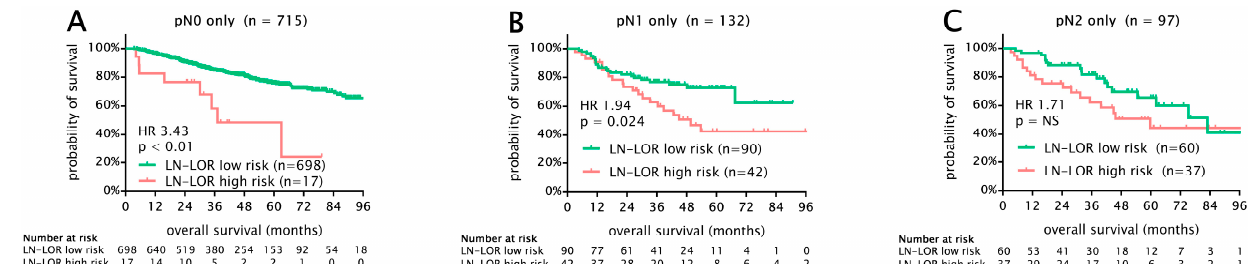
Figure 3. Kaplan–Meier survival analysis for OS in 944 patients with stage I-III NSCLC undergoing curative intent lobectomy. Survival analysis stratified by pN categories and LN-LOR risk groups. ( A ) OS in pN0 patients only. LN-LOR high risk was associated with significantly worse OS (5-year OS 76% vs. 48%, p < 0.01) among pN0 patients. Importantly, 17 patients in the LN-LOR high-risk group did not undergo adequate lymphadenectomy. ( B ) OS in pN1 patients only. LN-LOR high risk was associated with significantly worse OS (5-year OS 73% vs. 41%, p = 0.024) among pN1 patients. ( C ) OS in pN2 patients only. We found a non-significant tendency for worse OS in LN-LOR high-risk patients in the pN2 subgroup (5-year OS 67% vs. 45%, p = 0.11). Importantly, pN1 and pN2 LN-LOR low risk (median OS 87 and 83 months) and pN1 and pN2 LN-LOR high-risk patients (median OS 50 and 59 months) had similar survival. LN-LOR, lymph node log-odds ratio; NS, not significant;